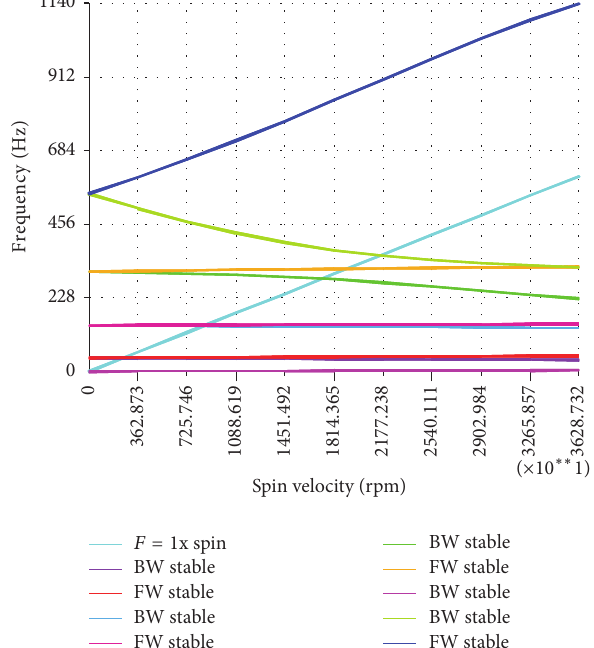
Figure 3: Campbell diagram of the rotor